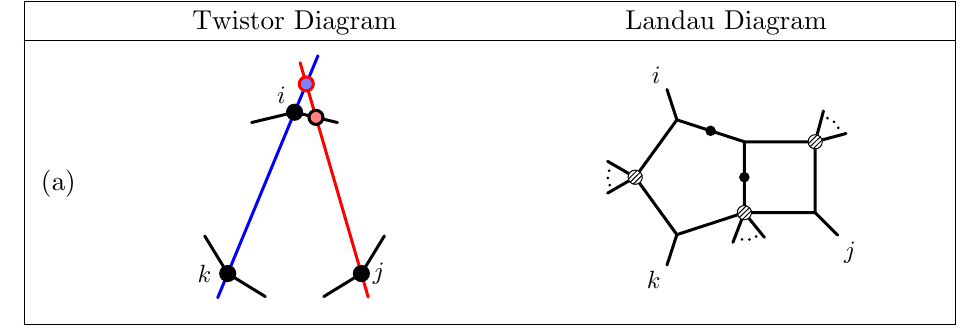
Table 1 . The twistor and Landau diagram describing a type (the unique type, for k = 0) of